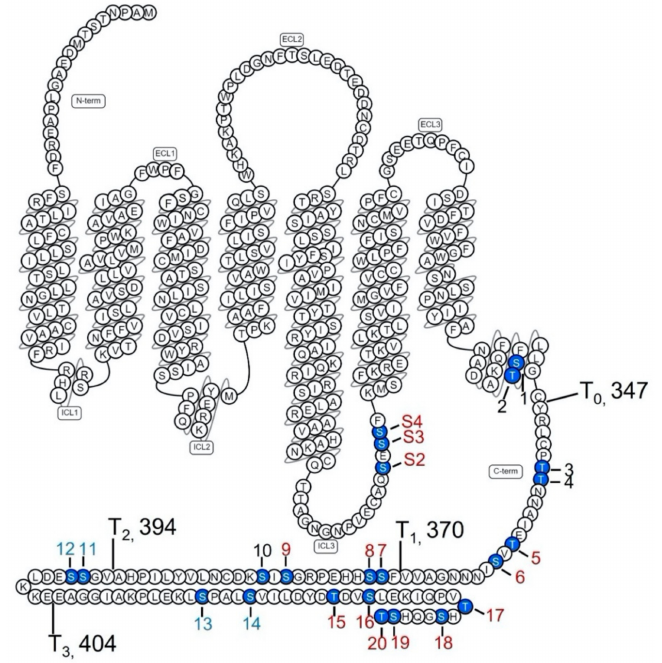
Figure 1. Diagram of the rat D1R illustrating the receptor mutants used in this study. Blue filled circles indicate serine and threonine residues that were mutated in the ICL3 and C-terminal tail. Four carboxyl terminal truncation mutants were also generated by inserting stop codons after amino acids 347 (T 0 ), 370 (T 1 ), 394 (T 2 ), or 404 (T 3 ). The T 0 truncation site was based on the observation that Cys-347 in the rat D1R is palmitoylated. The twenty serine and threonine residues in the C-terminus are numbered 1–20. Simultaneous mutation of these 20 residues refers to the “Tail Total” mutant. Simultaneous mutation of the eight serine and threonine residues in the distal C-terminus refers to the “S13–20” mutant. Simultaneous mutation of just the three Ser residues (S256, S258, and S259) in the ICL3 refers to the “S2/S3/S4” mutant. The GRK-mediated D1R phosphorylation sites determined in this study, as well as in Rankin et al. (2006) [28] are delineated using red numbering and lettering on the receptor diagram. Simultaneous mutation of these residues refers to the “GRK-null” mutant. The sites that are constitutively phosphorylated by GRK4 α are: T15, S16, S18, S19 and T20 [28]. PKC-mediated phosphorylation sites that were determined in Rankin and Sibley, 2010 are shown in blue numbering (11–14) on the receptor diagram. Note that residue S4 (S259) in the ICL3 has been identified as being phosphorylated by both GRKs and PKCs [14,27]. The D1R snake diagram was modified from GPCRdb.org